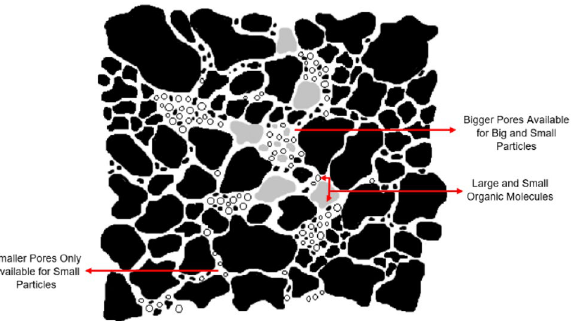
Figure 1. Schematic diagram showing the tortuosity of a porous media with narrow and wide irregular